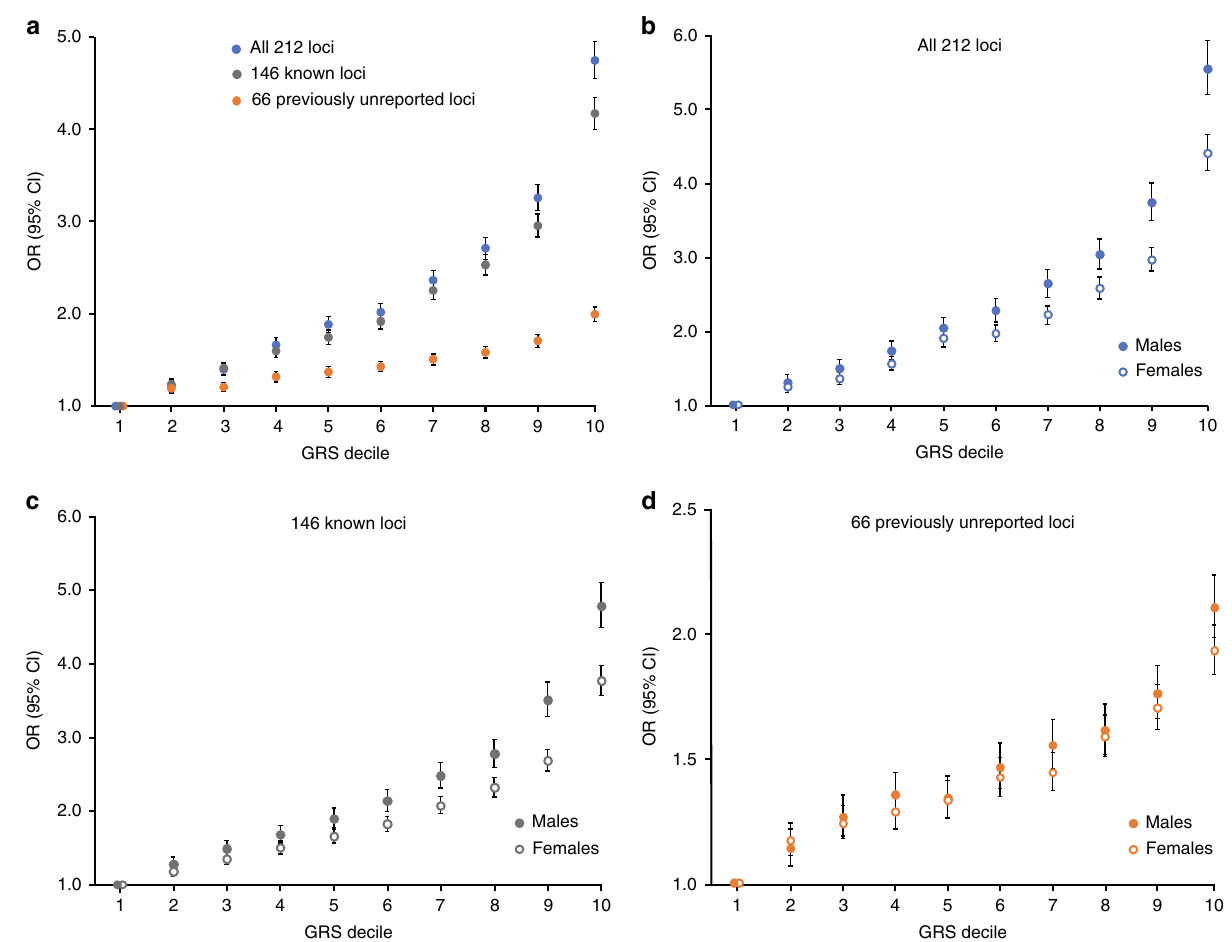
Fig. 3 Cumulative genetic burden and risk of asthma in the UK Biobank. a Individuals in the highest decile for three weighted genetic risk scores (GRS) based on the known or previously unreported susceptibility loci have signi fi cantly elevated risk for asthma compared to the lowest decile. b – d Compared to females, cumulative genetic risk for asthma was more signi fi cantly pronounced in males across the entire spectrum of sex-speci fi c weighted GRS constructed from all 212 ( P -int = 6.1 × 10 − 18 ), 146 known ( P -int = 3.0 × 10 − 18 ), and 66 previously unknown ( P -int = 0.01) loci. Interactions with sex were also signi fi cant when comparing the highest versus lowest decile for the GRS constructed from all 212 ( P -int = 7.3 × 10 − 10 ), 146 known ( P -int = 1.9 × 10 − 10 ), and 66 previously unknown ( P -int = 0.03) loci. Each decile in the GRS analyses included 39,386 subjects when both sexes were combined ( a ) or 18,318 males and 21,068 females when strati fi ed by sex ( b – d ). Data are shown as ORs with 95% CIs, as calculated by logistic